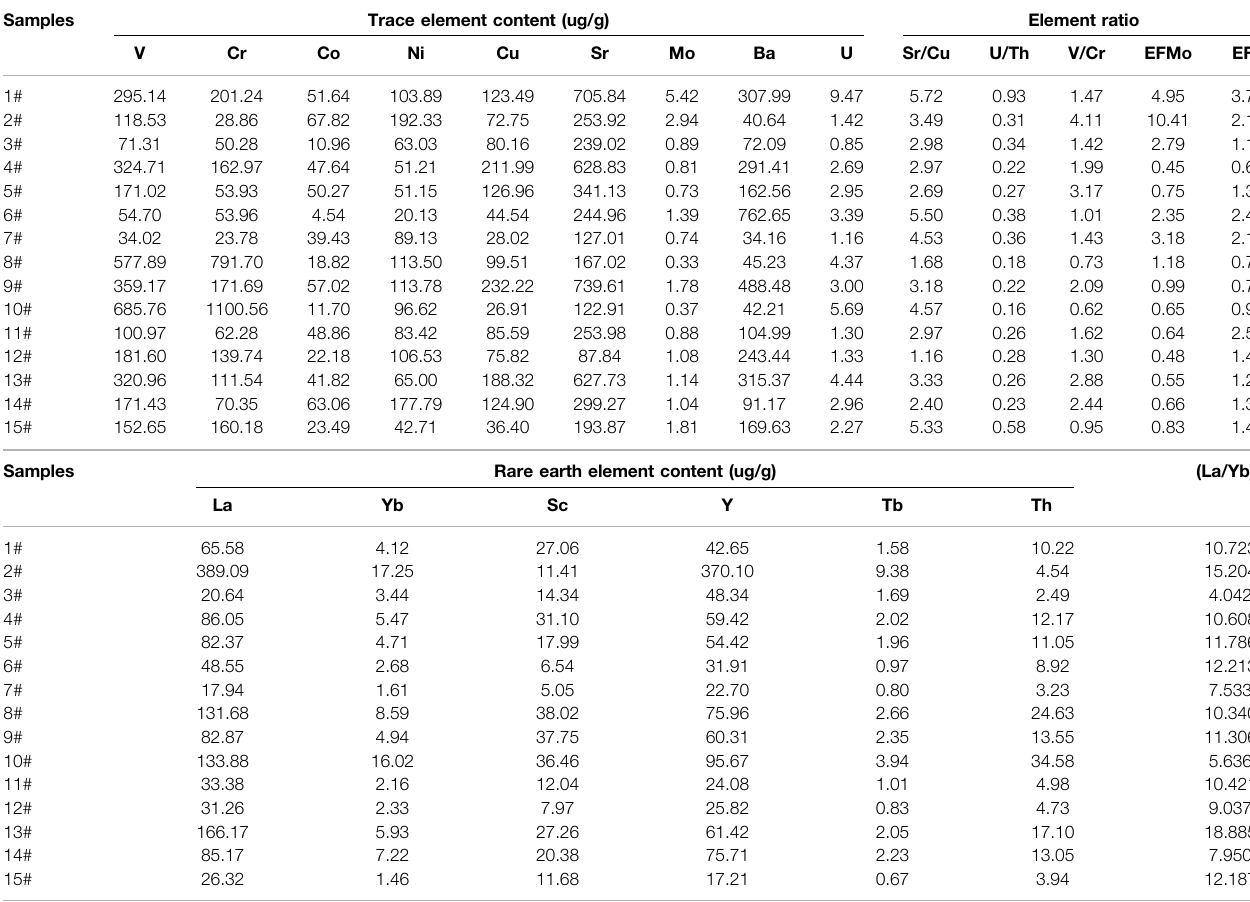
TABLE 3 | | Trace element contents, rare earth element contents, and related parameters of mud shale samples from the Longtan Formation. Samples Trace element content